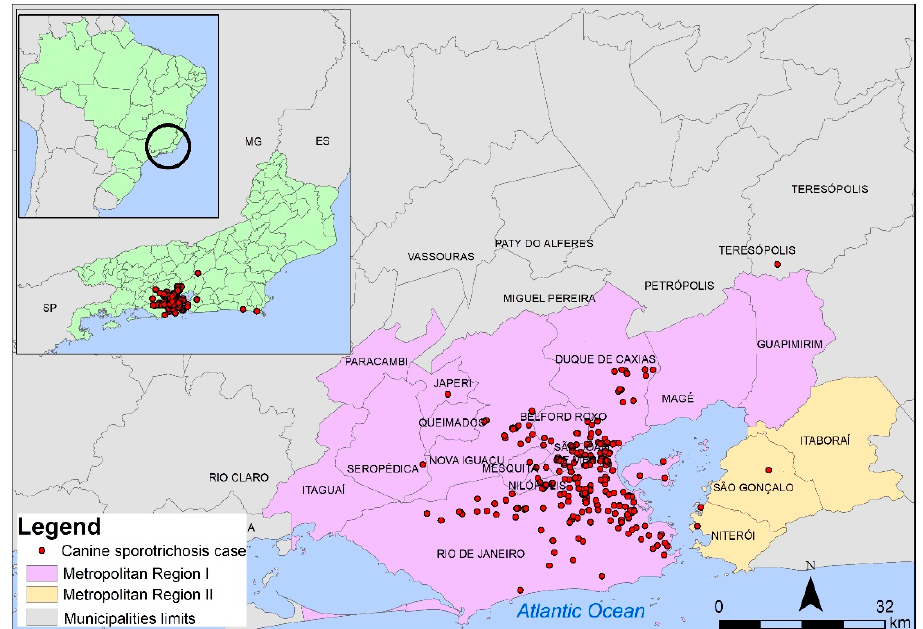
Figure 2. Distribution of cases of canine sporotrichosis in the state of Rio de Janeiro, Brazil, between 1998 and 2018. The limits of the municipalities are shown as black lines. Red dots indicate cases of canine sporotrichosis.